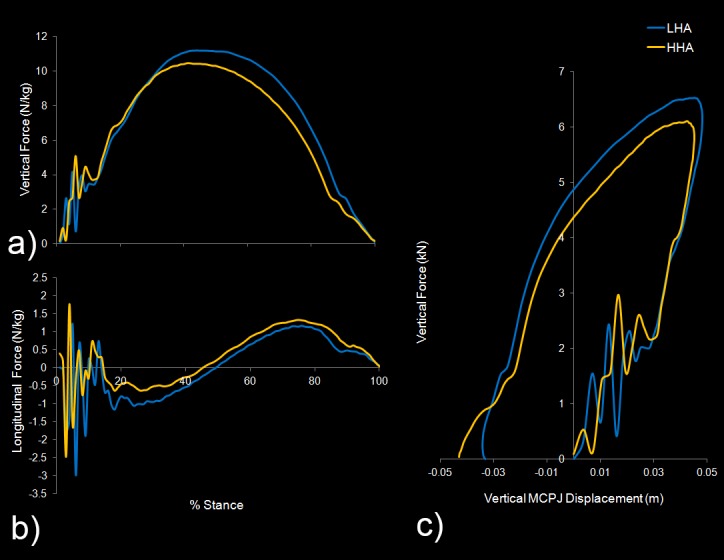
Graphical data of the functional consequences of unevenness in one horse with a difference in dorsal hoof wall angle of 8 degrees.a) Vertical force (N/kg) during the stance phase showing the difference in peak force and time to peak force between limbs. b) Longitudinal force (N/kg) during the stance phase showing the difference in braking and propulsive force and the time of the transition from braking to propulsion. c) Stiffness curve for each limb highlighting how maximum MCPJ displacement occurs prior to peak vertical force in the LHA limb.